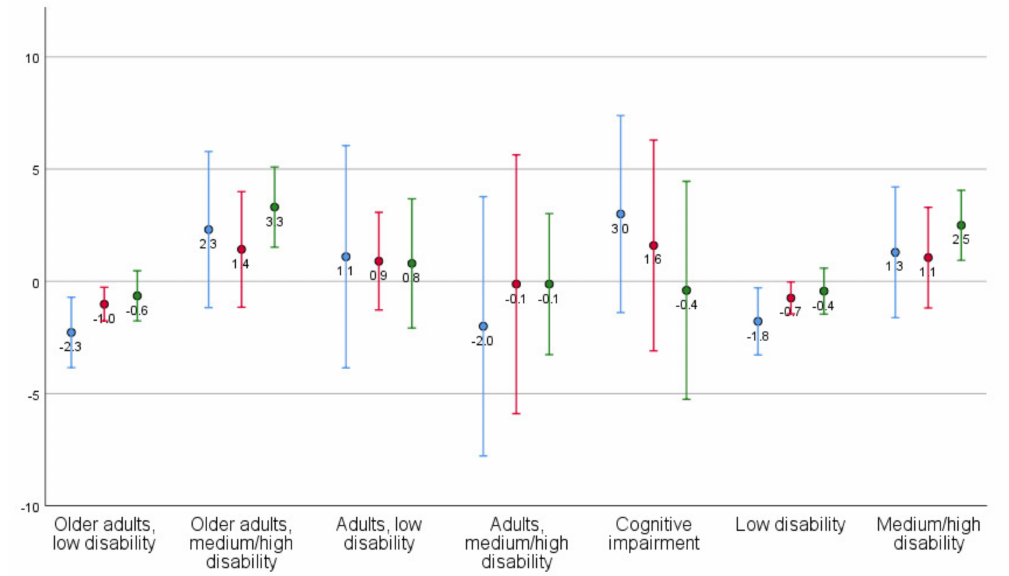
Figure 2. Mean changes (dots) with standard deviation (lines) in Usability in the home, per client profile and aggregated client profiles (blue line = self-care, red line = social, green line = outdoor leisure). Values > 0 indicates improvement (i.e., higher usability) from T1 to